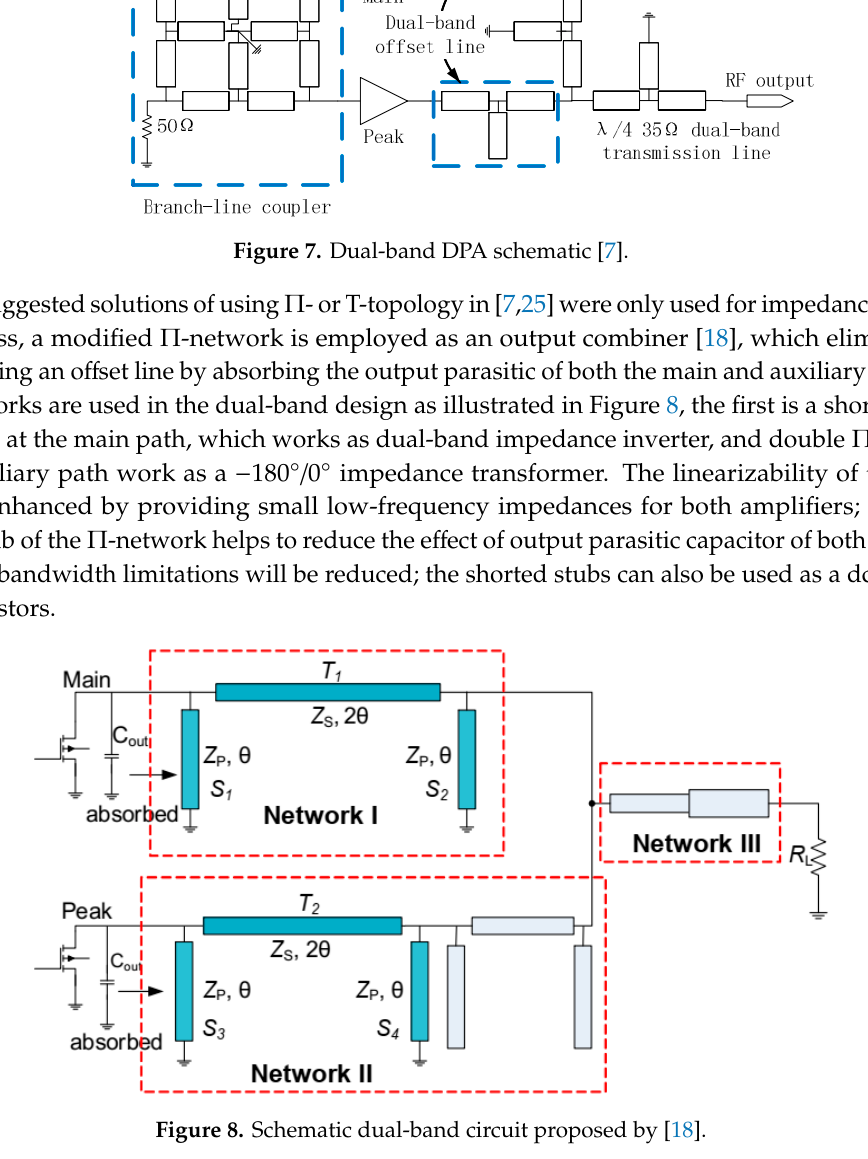
Figure 8. Schematic dual-band circuit proposed by [18].